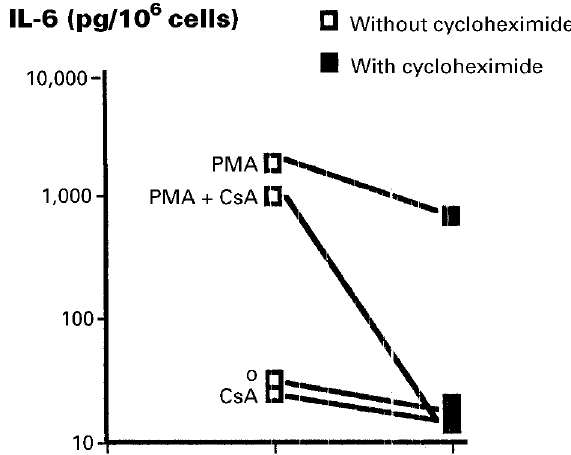
FIG. 2. Effect of cycloheximide on the action of CsA in U937 cells. The effect of cycloheximide was evaluated in differ- entiated cells. Although overall cycloheximide decreased both basal and stimulated cytokine secretion, the inhibitory effect of CsA persisted in all cases. Definition of abbrevia- tions; CsA, cyclosporin A; IL-6, interleukin-6; PMA, phorbol myristate acetate.